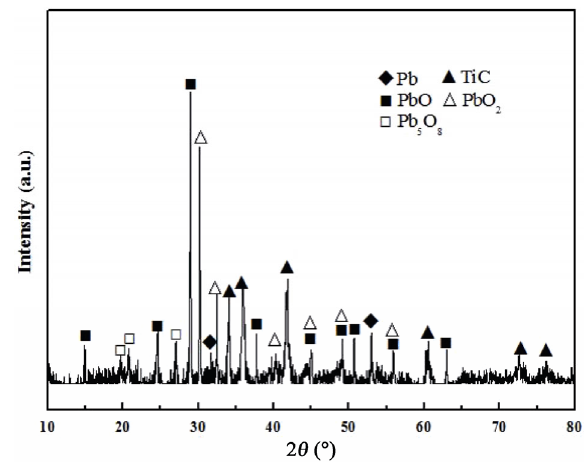
Fig. 6 DSC curve of a mixture of Ti/Pb/TiC powders.